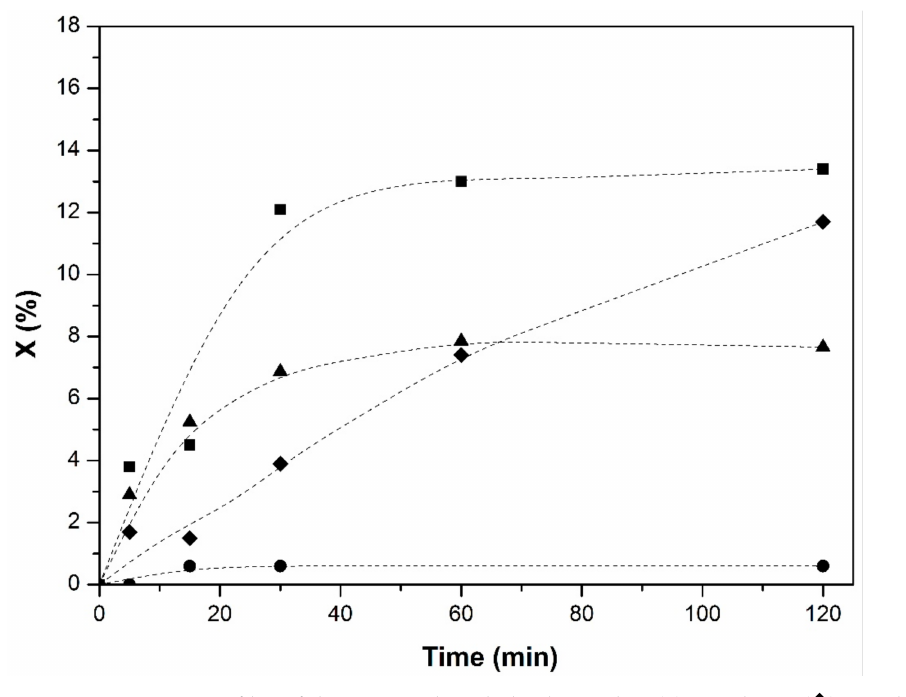
Figure 8. Reaction profiles of the C@Fe–Al 2 O 3 hybrid samples: ( • ) C@Al-723, ( ) C@Al-823, ( ) C@Al-923, and ( ) C@Al-1023.